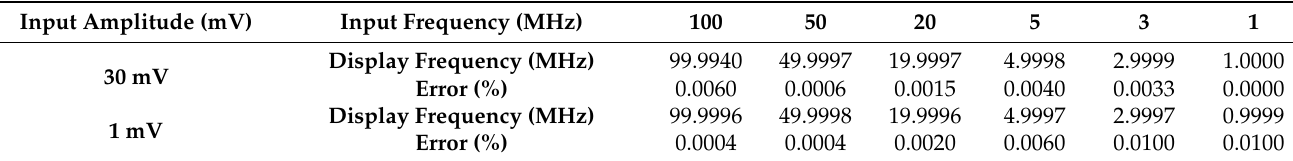
Table 1. High-frequency sine channel test.